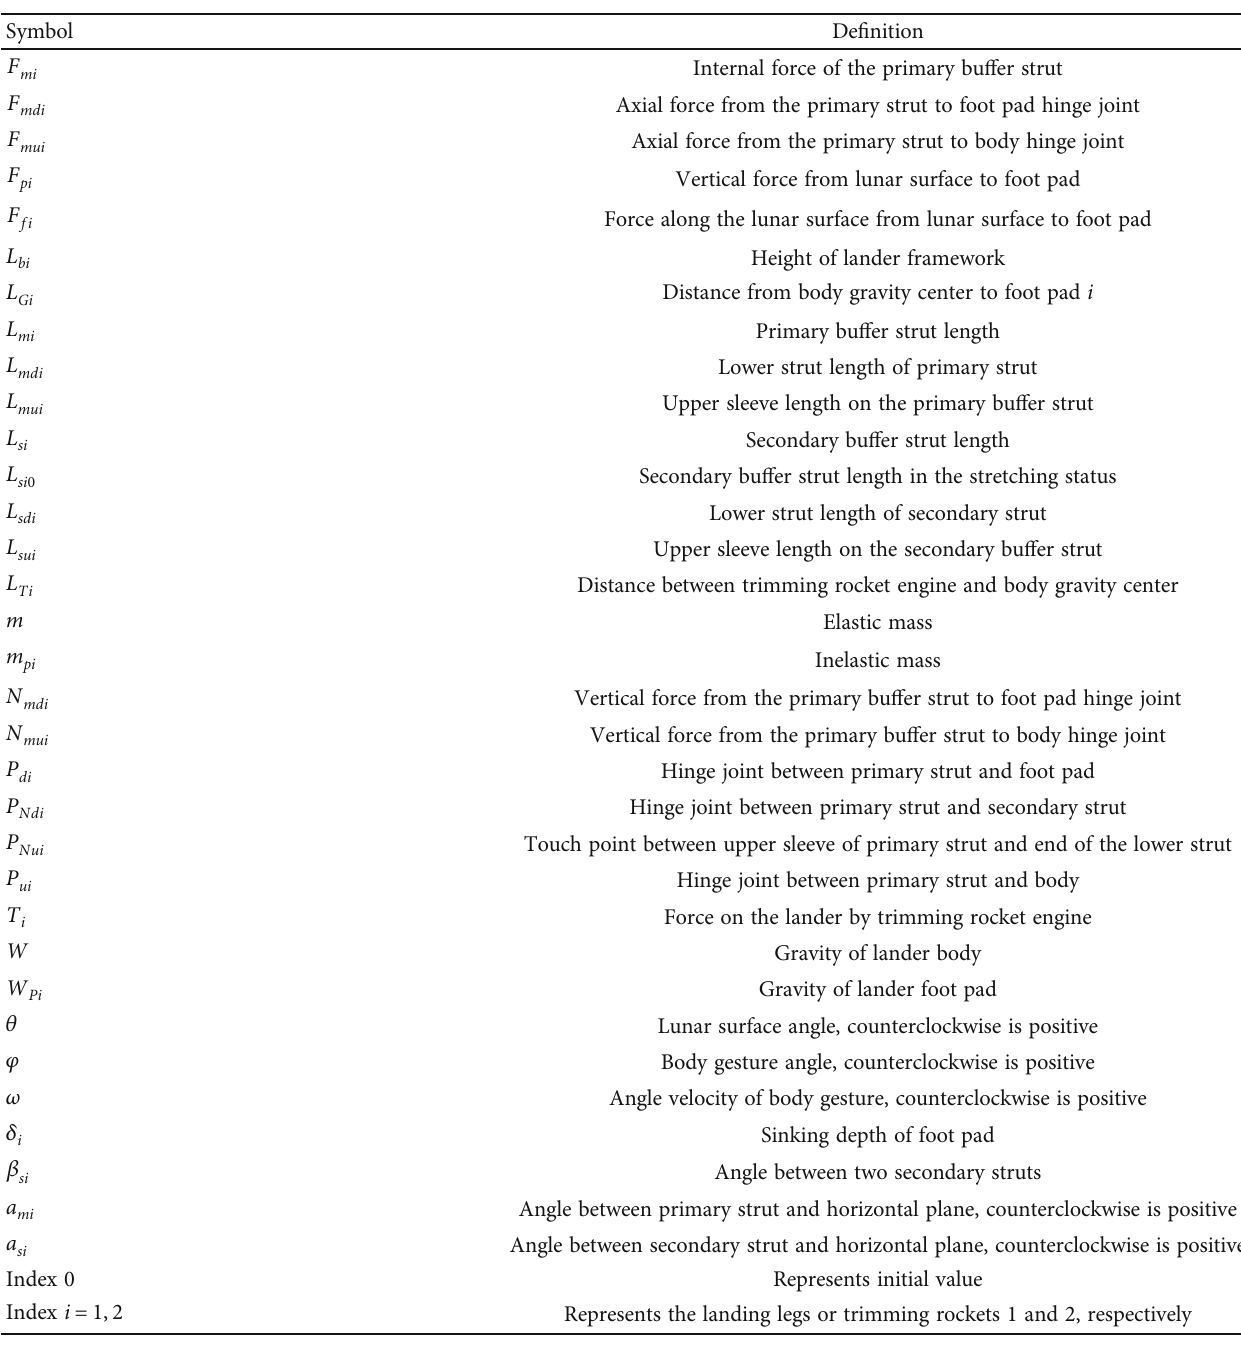
Table 1: Noti fi cations of landing force of lunar lander under 2-2 mode.